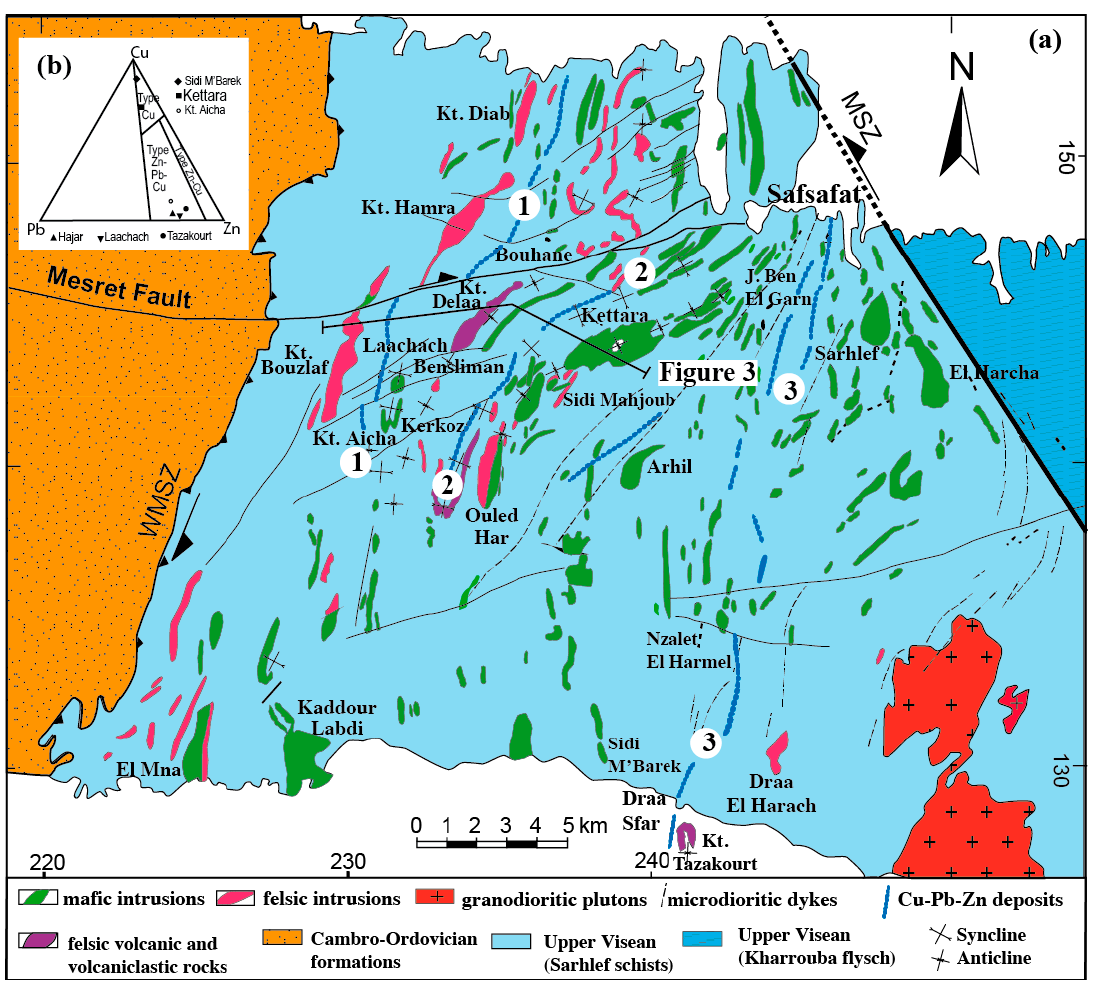
Figure 2. ( a ) Regional distribution of the massive sulphide deposits in the Central Jebilet (modified from [16]). The numbers 1, 2, 3 refer to the western, central, and eastern lineaments controlling the massive sulphide orebodies. ( b ) Plot of the main sulphide deposits in the Cu-Pb-Zn classification of Large [54]. The white color represents undifferentiated post-Paleozoic sedimentary units.